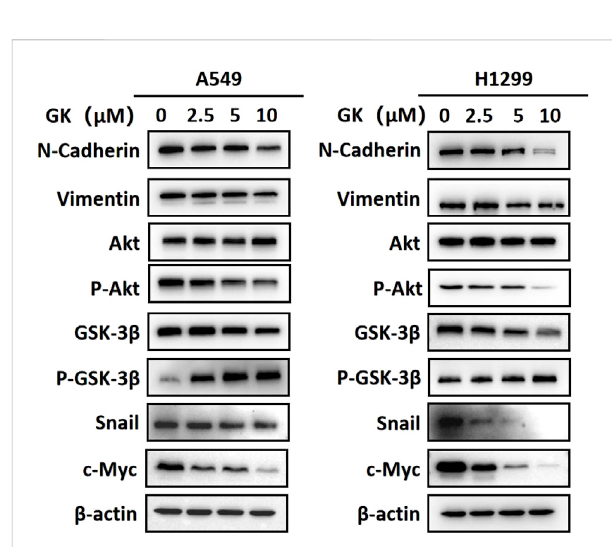
FIGURE 10 GK inhibits EMT in A549 and H1299 cells by modulating the AKT/ GSK-3 β /Snail pathway and Wnt/ β -catenin pathway. Western blotting analysis of protein expression in the indicated A549 and H1299